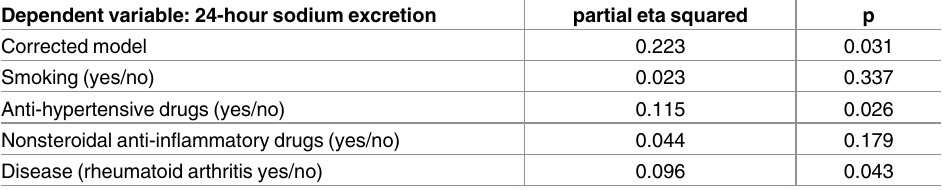
Table 2. Multi-adjusted analysis of sodium excretion in early RA and matched